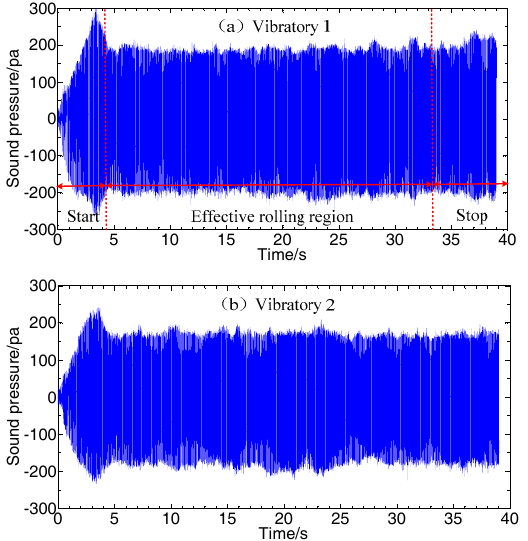
Figure 13. Original acoustic signal data collected from Strip 1 by acoustic field microphone 3.